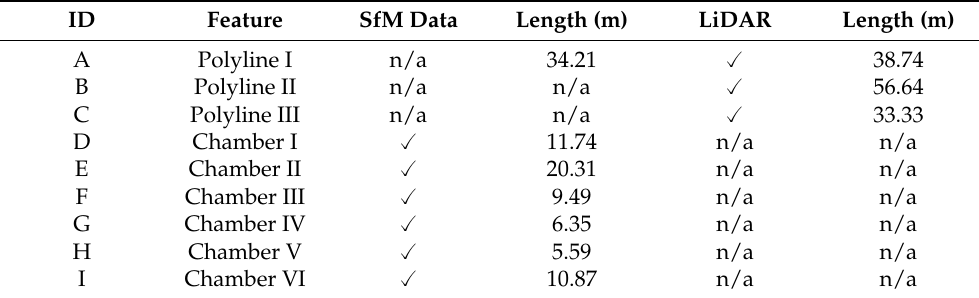
Table 7. The lengths of the archaeological features identified in this study using SfM and LiDAR data analysis.